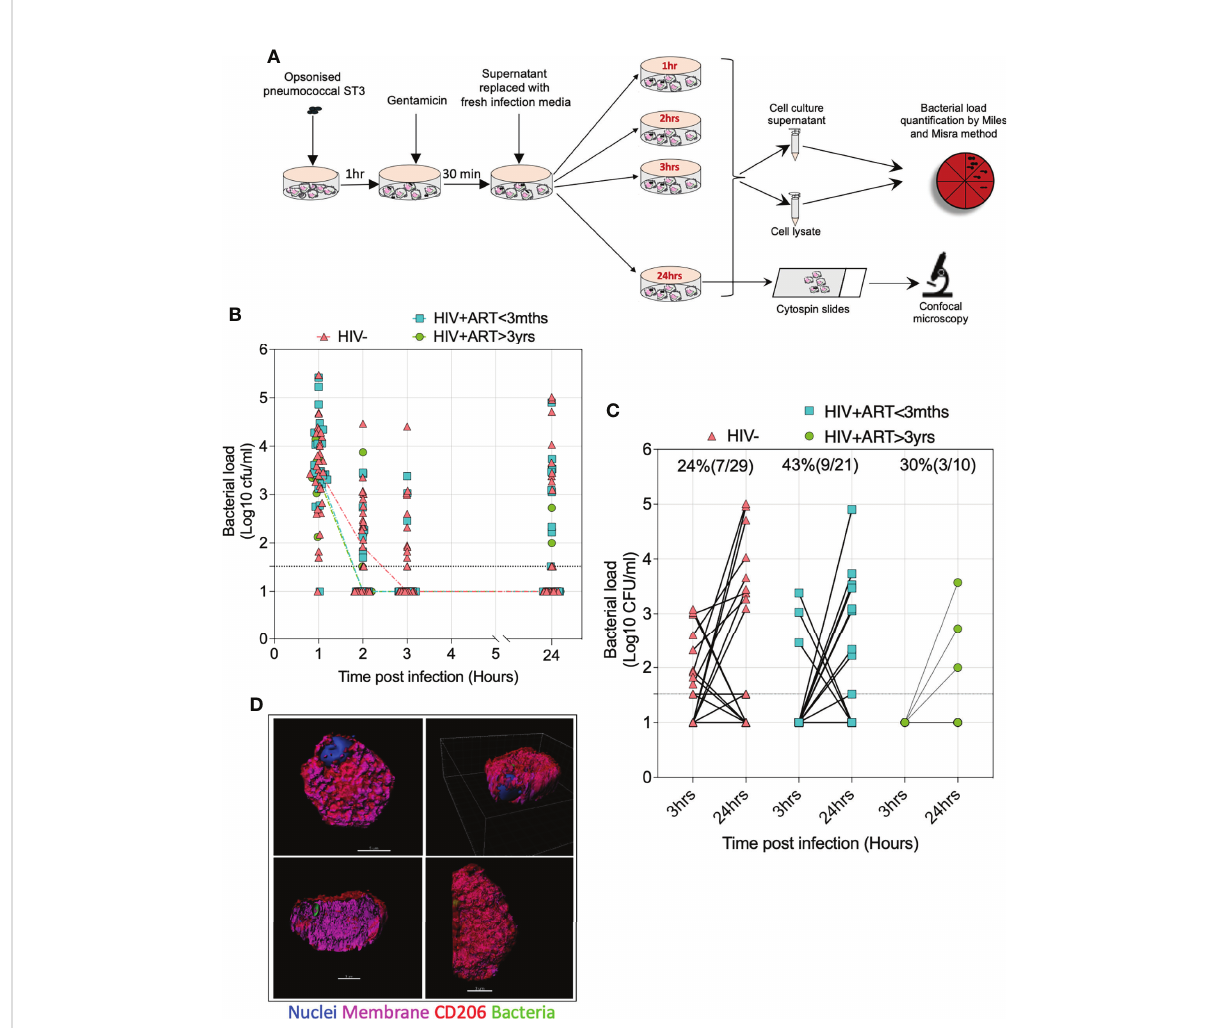
FIGURE 3 Intracellular survival of S. pneumoniae within AMs. (A) Schematic outlines the gentamicin protection experimental design. (B) Graph depicts the AMs intracellular bacterial load p.i at the time points indicated. (C) Samples of AMs from individuals with undetectable bacteria at 3 hours post infection (p.i) but having detectable pneumococcal persistence at 24 hours p.i. (D) Representative 3D Z-stack images on different planes demonstrating internalised S. pneumoniae -ST3 within CD206 + AMs (WGA; cell membranes – purple; DAPI – nucleus, red – monoclonal anti-CD206) with S. pneumoniae -ST3 (bacteria capsule, FITC – green). Scale bars, top left panel =5 m m; top right panel =3 m m, bottom left panel =3 m m; bottom right panel =3 m m. Asymptomatic individuals; HIV-uninfected (n=29), HIV-infected on ART <3 months (n=21), HIV-infected ART>3 years (n=10). Statistics were calculated using Chi-squared test and Wilcoxon signed rank